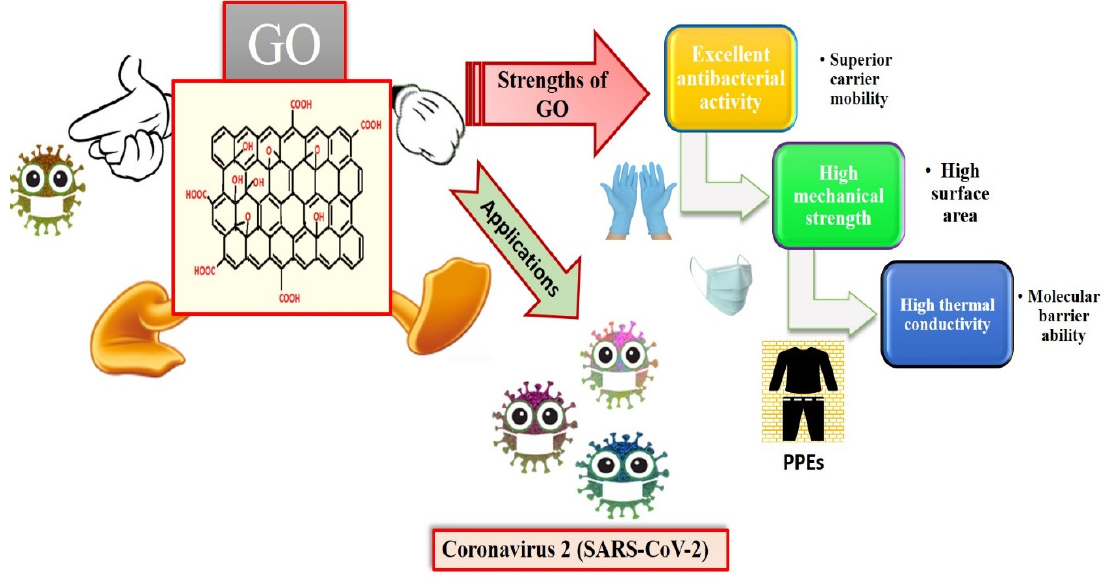
Figure 6. Applications of graphene oxides (GO) and their strengths (reproduced with permission from Hashmi, A. et al., 2022, Mater. Today Adv., 13, 100208 [51]).